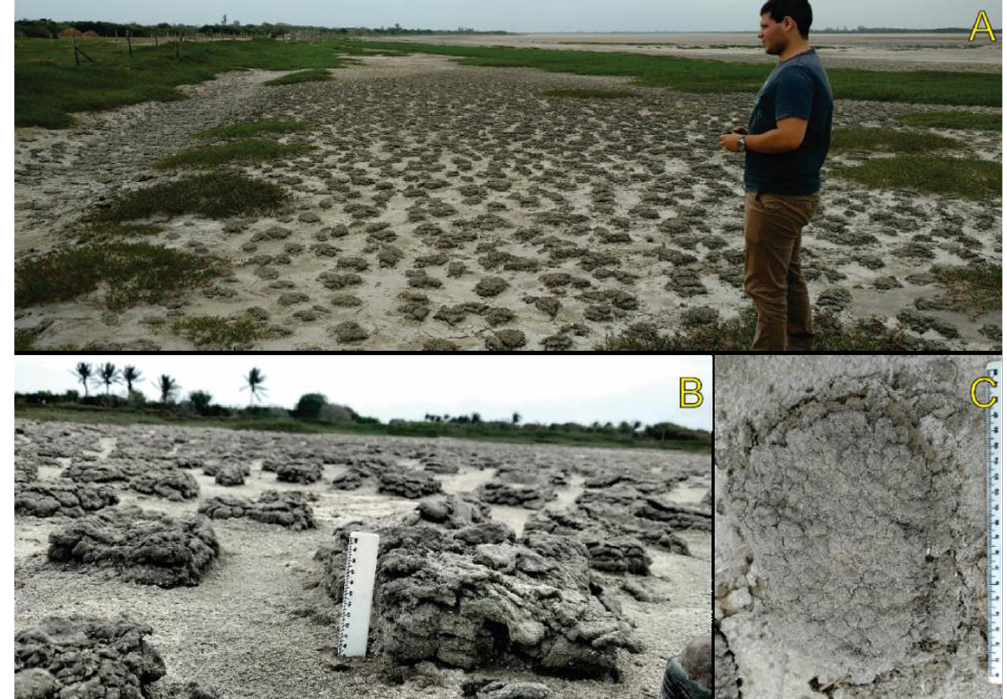
Figure 7 - Colloform mat, demonstrating positive relief, observed in the southern portion of Lagoa Salgada. A) Region with colloform